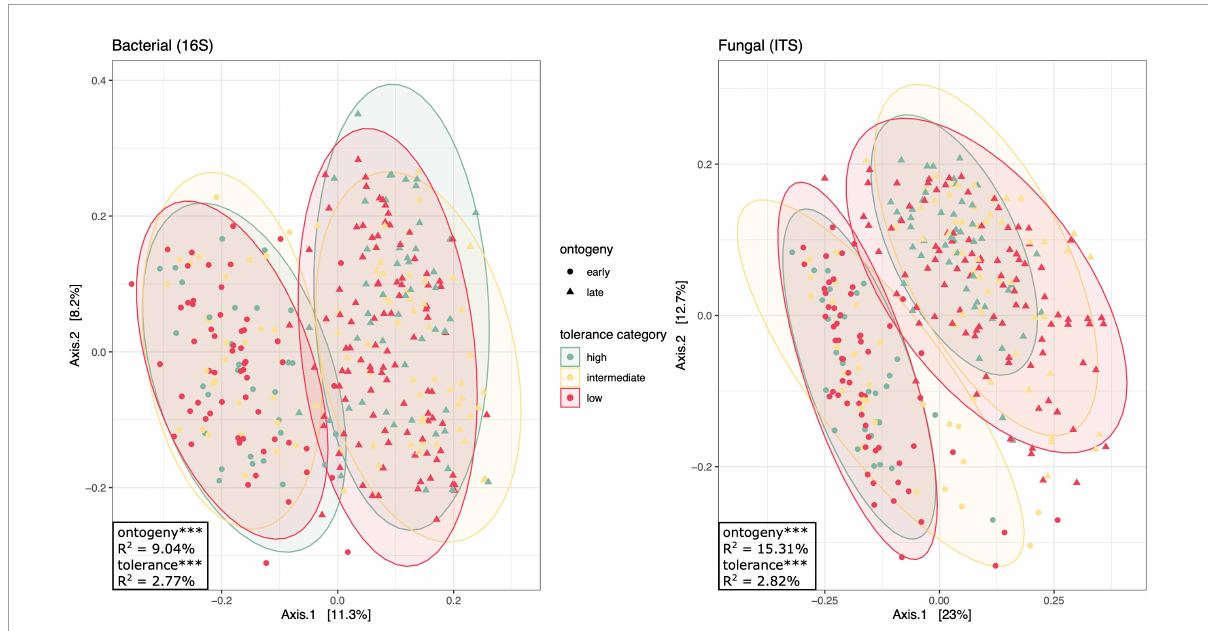
FIGURE4 Principal coordinates analysis of bacterial and fungal communities separated by plant ontogeny (shape: early or late) and tolerance category (color: high, intermediate, or low). Drawn around each of the six ontogeny × tolerance category groups are 95% confidence ellipses. This figure uses the same ordination as Supplementary Figures 4 , 6 , but colors points by domestication status, rather than line ( Supplementary Figure 4 ) or domestication ( Supplementary Figure 6 ). Factors that explain a significant proportion of community variation as determined by a PERMANOVA of Bray–Curtis dissimilarity are displayed in the bottom-left corners (See Supplementary Table 6 ): *** denotes p < 0.001.